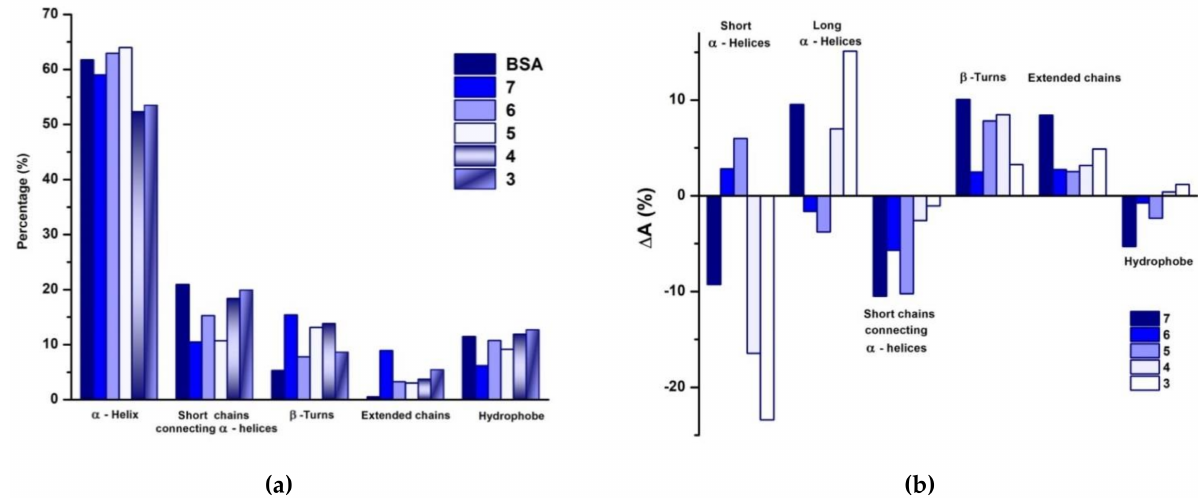
Figure 3. Distribution of the secondary structures of BSA in the PULL/PVA/BSA mixtures, obtained by fitting the Amide I band: ( a ) the histogram of the secondary structures; ( b ) conformational changes in BSA in presence of the polymer mixture, calculated as variations in the intensity of the component sub-bands of Amide